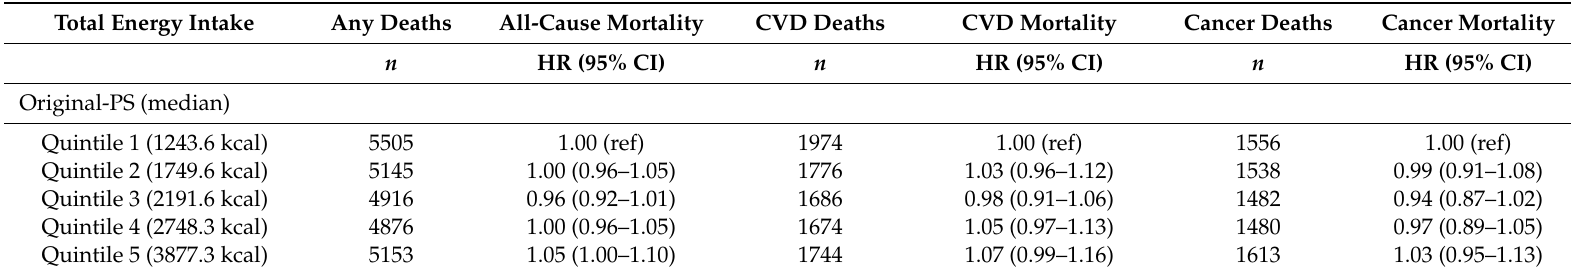
Table 2. Hazard ratios (HRs) (95% confidence intervals (CIs)) for all-causes, cardiovascular disease (CVD), and cancer mortality according to quintiles of total energy intake estimated from a food frequency questionnaire either using an original-portion size (Original-PS) or a gender specific-portion size (GS-PS) among men ( n = 70,142) in the Multiethnic Cohort Study, 1993–2014 1